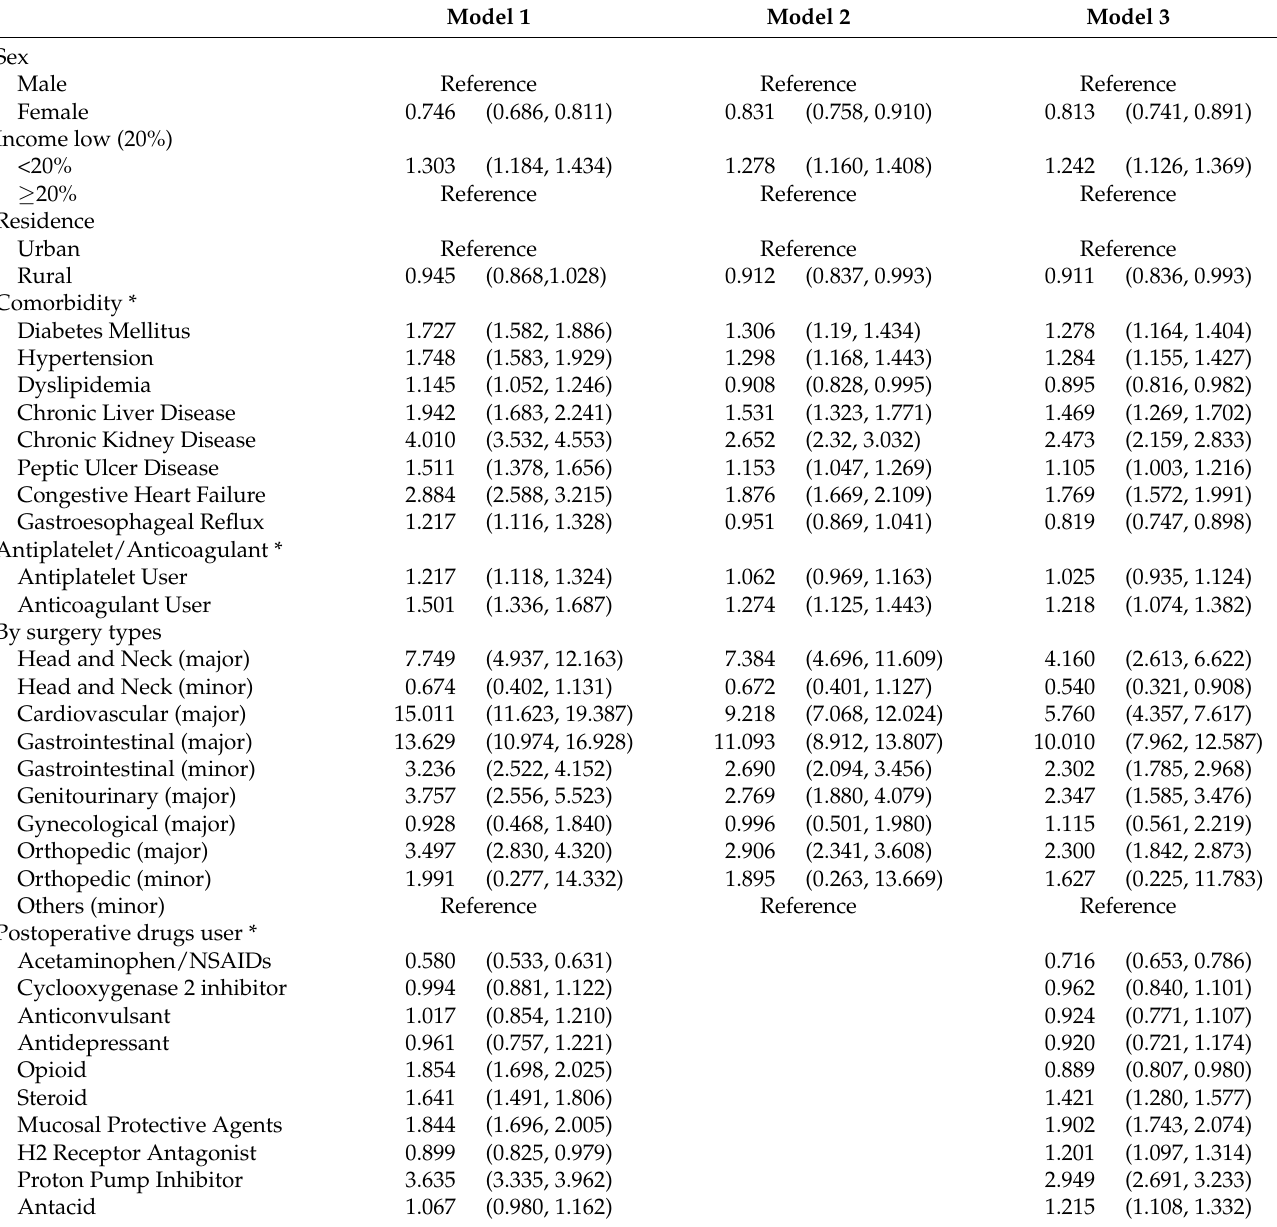
Table 4. Logistic regression analysis for subjects aged 65 or more (odds ratio, 95% confidence